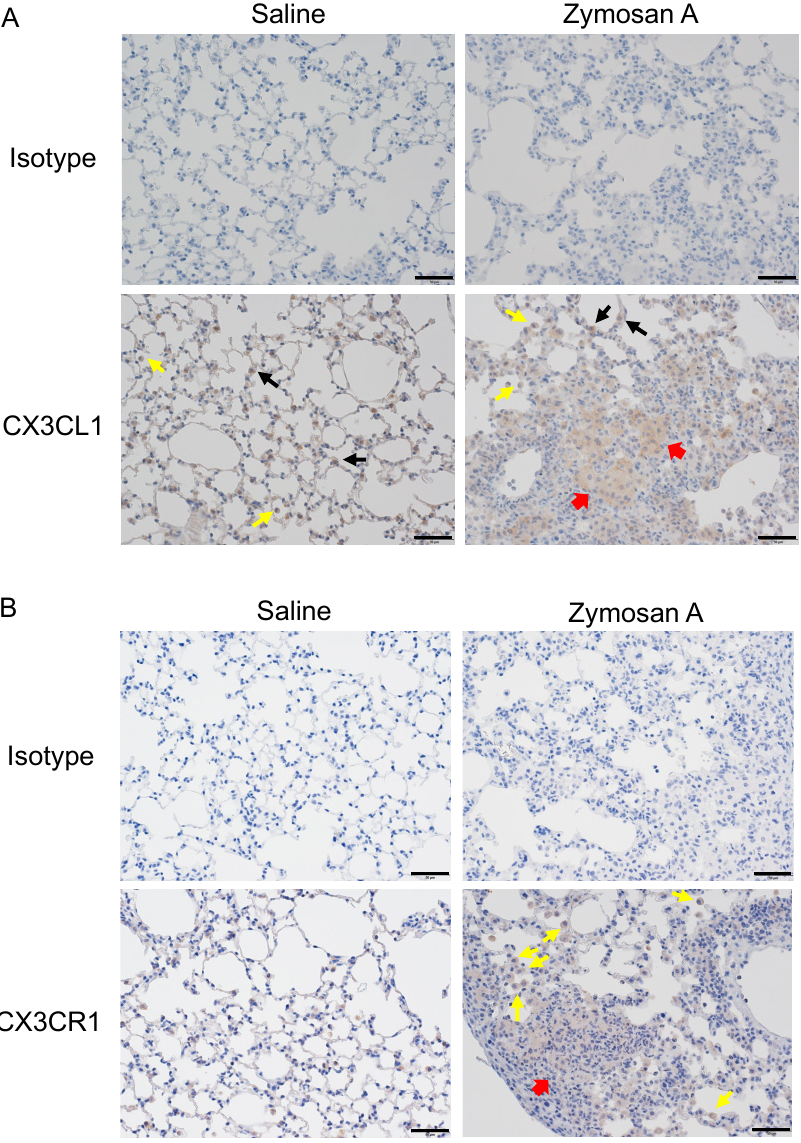
Figure 2. Immunohistochemical (IHC) analysis of CX3CL1 and CX3CR1 in lung tissue from SKG-ILD mice. Lung tissue was obtained as described in Figure 1. Representative images of the IHC analysis of CX3CL1 or CX3CR1 are shown. ( A ) Images of IHC for CX3CL1. Arrows indicate CX3CL1-positive alveolar epithelial cells (black arrows), alveolar macrophages (yellow arrows), or CX3CL1-stained areas in fibroblastic foci (red arrows). ( B ) Images of IHC for CXC3R1. Arrows indicate CX3CR1-positive alveolar macrophages (yellow arrows) or CX3CR1 + cell-infiltrating areas in fibroblastic foci (red arrows). Original magnification of ×200. Scale bars indicate 50 μ m.